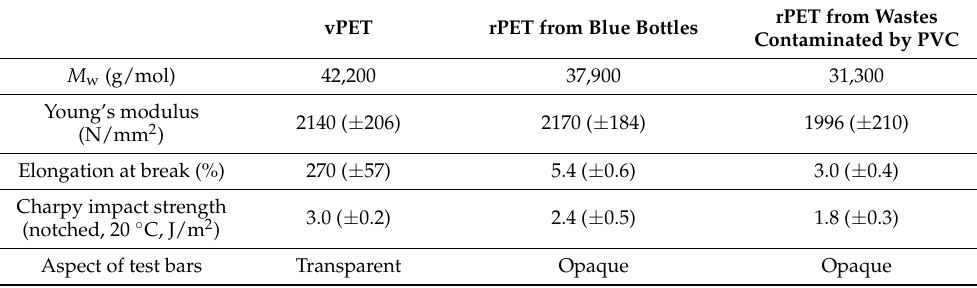
Figure 16. Effect of mechanical reprocessing cycles on ( a ) PDI and viscosity, ( b ) crystallinity, ( c ) impact and Young’s modulus, and ( d ) stress and strain at break of PET. Reproduced with permission [315], 2012, Elsevier. Table 4. Comparative properties of vPET and rPET. Reproduced with permission [45].